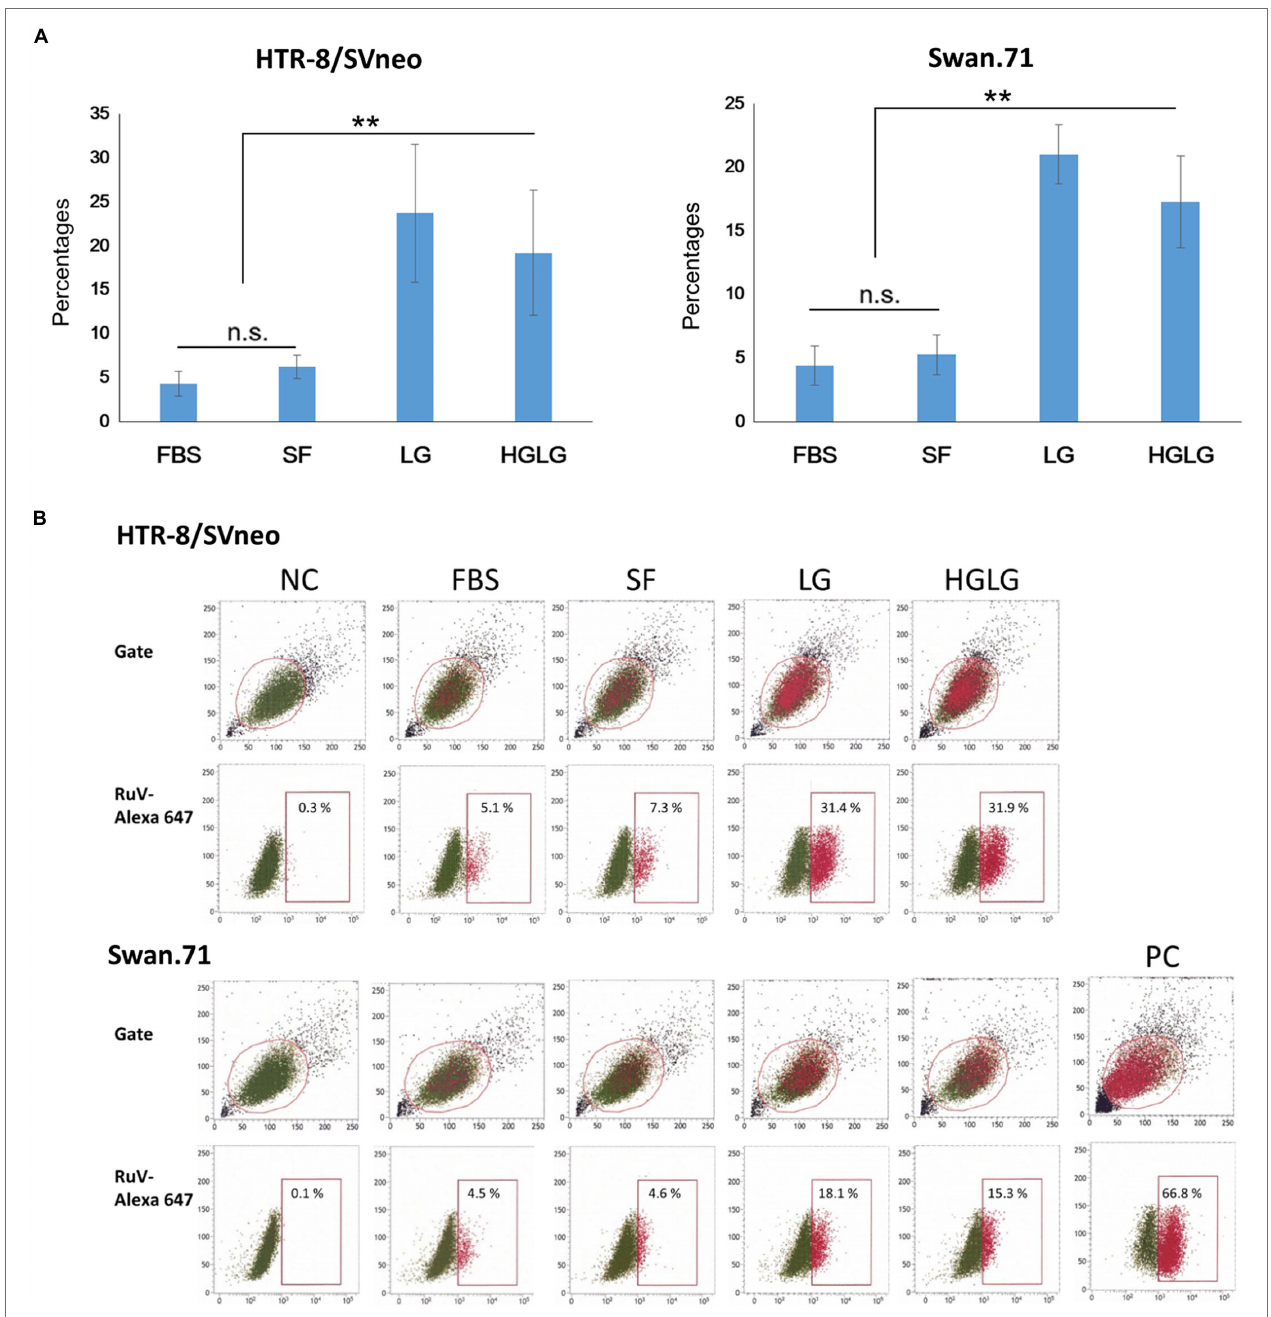
FIGURE 3 | (A) Percentages of the studied trophoblast, HTR-8/SVneo and Swan.71 cells positive for RuV as determined by FCM analysis at 24 hpi. Trophoblast cells were seeded at a density of 5 × 10 3 cells/well in a 96-well plate. After LG stress treatments and RuV infection at an MOI of 5–10, the cells were collected at 24 to 48 hpi and labeled with a Live/Dead Fixable Near-IR Dead Cell Stain Kit to exclude dead cells from analysis. Intracellular staining was performed with a mouse monoclonal anti-rubella viral capsid antibody followed by an Alexa-488 conjugated goat anti-mouse IgG (H + L) secondary antibody. Mock-infected cells using culture medium were used as negative controls (NCs). Vero cells infected with RuV performed in parallel were used as positive controls (PCs). The results are expressed as the mean of at least triplicate experiments in each group, and each graph is representative of three independent experiments. ** p < 0.01. (B) Representative images of flow cytometry analysis. Numbers displayed inside each panel correspond to the percentage of the cells positive for RuV capsid protein of the parent gated